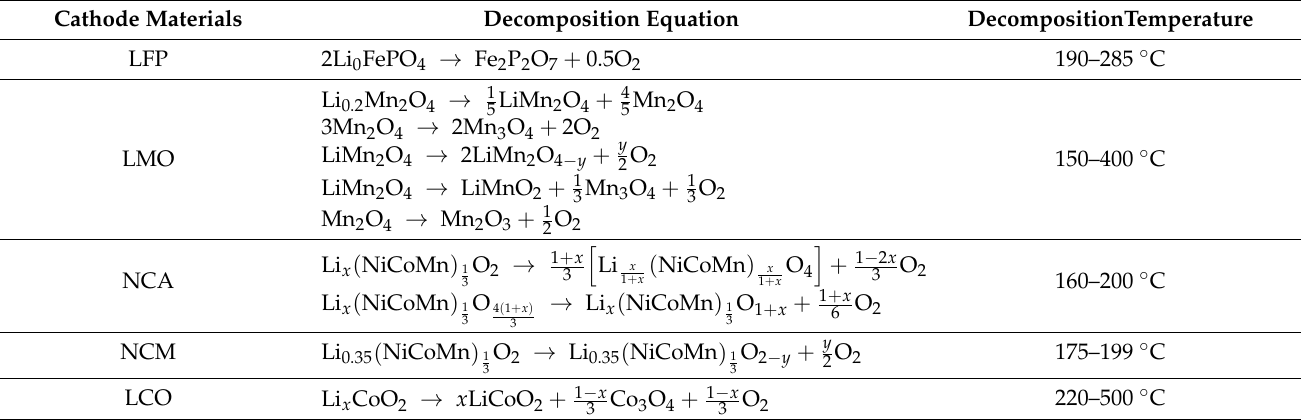
Table 1. Decomposition reactions for different cathode materials